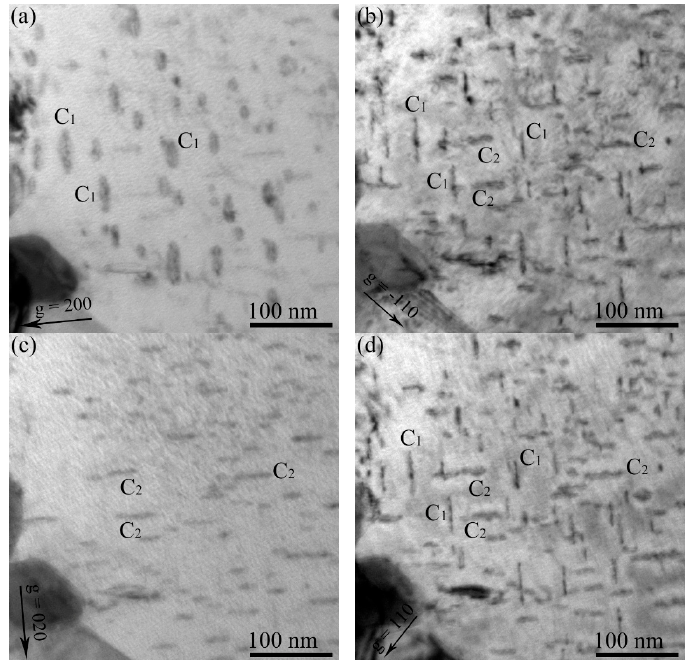
Figure 5. TEM bright field micrographs of dislocation loops in the specimen irradiated at 3 × 10 20 H + • m − 2 at 723 K. ( a ) g = 200, ( b ) g = − 110, ( c ) g = 020, and ( d ) g = 110 near the pole [001]. The Burgers vector of family C 1 loops is b = a 0 <100>, and the family of C 2 loops is b = a 0